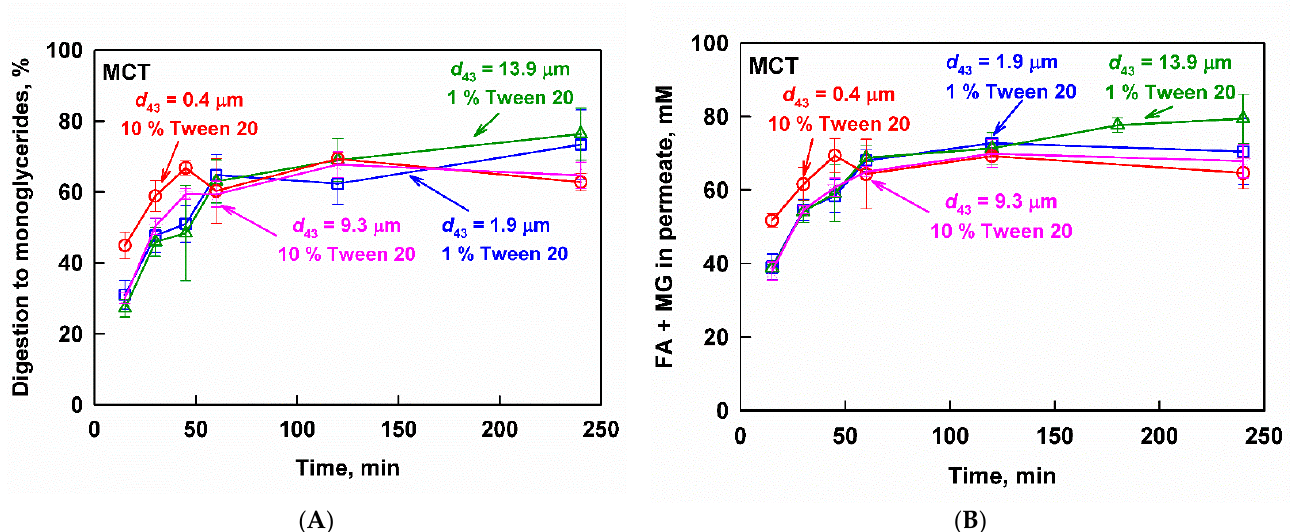
Figure 6. ( A ) Digestion and ( B ) fatty acids (FA) and monoglycerides (MG) measured in the aqueous phase after filtration of fenofibrate-loaded MCT emulsions with d 43 = 0.4 µm (10 wt% emulsifier, red circles), d 43 = 1.9 µm (1 wt% emulsifier, blue squares), d 43 = 9.3 µm (10 wt% emulsifier, pink stars) and d 43 = 13.9 µm (1 wt% emulsifier green triangles) as a function of time, at simulated intestinal conditions.